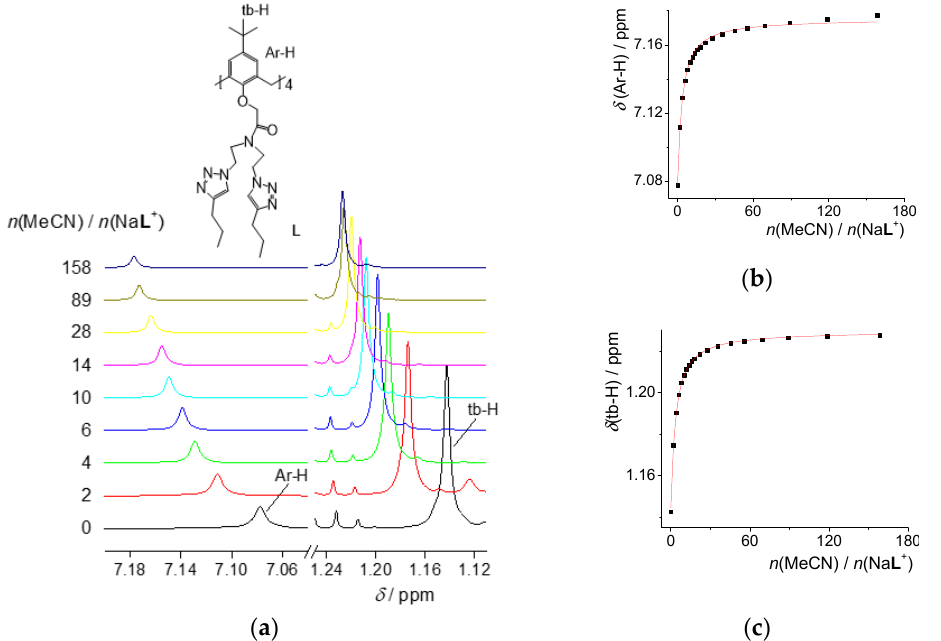
Figure 5. ( a ) 1 H NMR titration of Na L ClO 4 ( c = 6.00 × 10 − 3 mol dm − 3 , V 0 = 500 μ L) with MeCN ( c = 5.935 mol dm − 3 ) in CDCl 3 at 25 °C. Selected 1 H NMR spectra acquired during titration; augmented